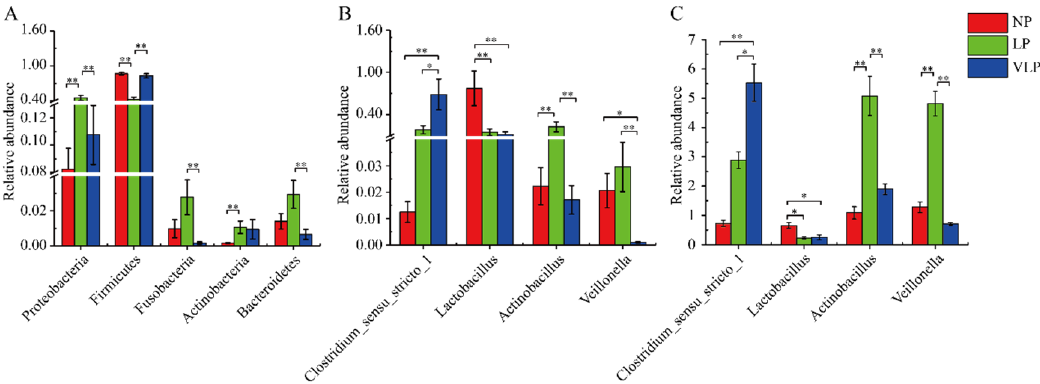
Figure 3. Kruskal-Wallis rank sum test analysis histogram. The bacterial phyla ( A ), genera ( B ), and qPCR ( C ) among NP, LP, and VLP. Bacterial taxa with mean relative abundance greater than 0.1% in least one group are included. Values are expressed as mean ± SE. The symbols represent significant difference among NP, LP, and VLP, ** p < 0.01, * p < 0.05, NP = normal protein; LP = low-protein; VLP = very low-protein.